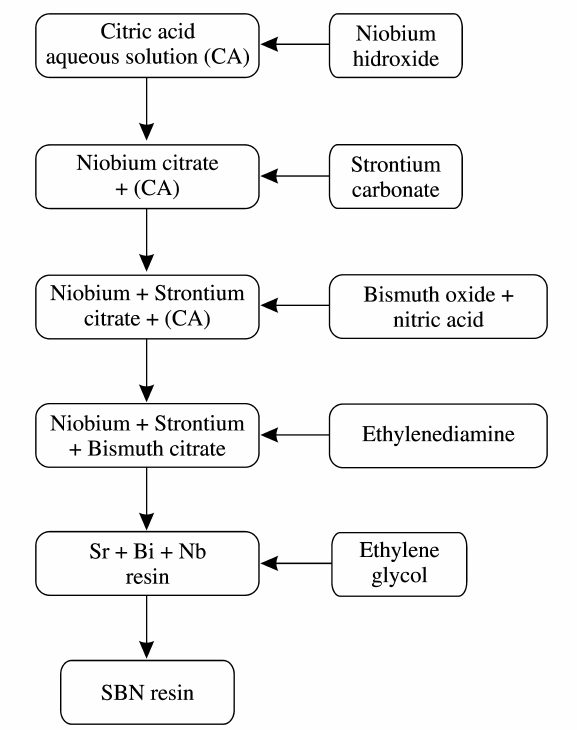
Figure 1. Flowchart for preparation of SBN